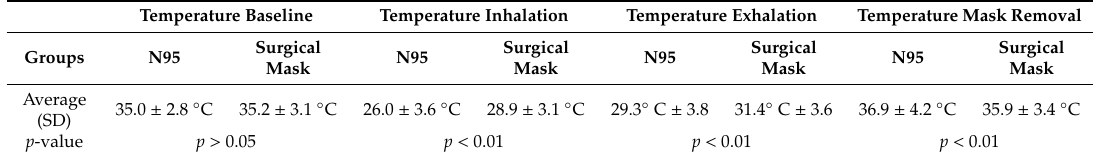
Table 2. Infrared thermal measurements of the perioral region surface at the baseline during the mask wearing and after the device removal (mean, SD. Student’s t -test).